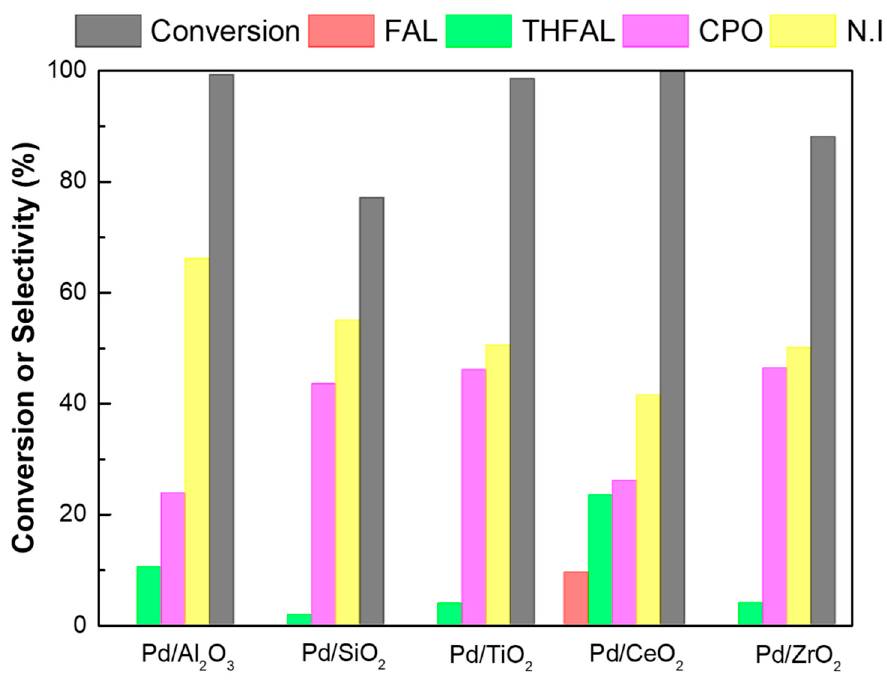
Figure 9. Conversion and product distribution in furfural hydrogenation over Pd based catalysts. Reaction conditions: furfural (2.5 g), distilled water (100 mL), catalyst (0.1 g), H 2 pressure (20 bar), reaction temperature (150 °C), reaction time (4 h), and stirring rate (500 rpm).